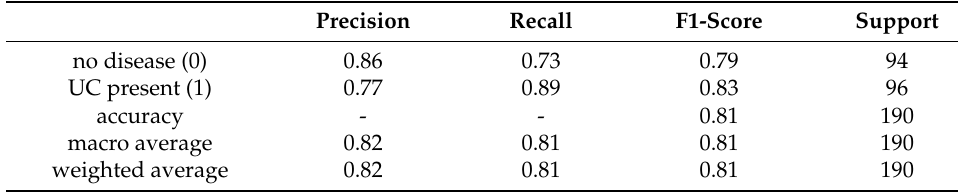
Table 4. Metrics for the random forest Machine Learning model for UC prediction.